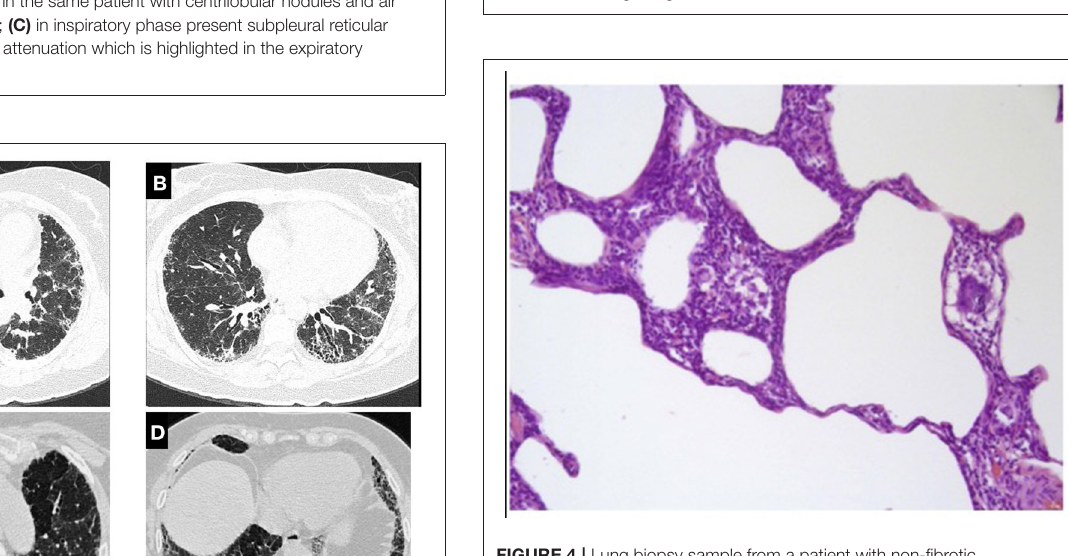
has experience with this technique), or surgical lung biopsy where samples of two different lobes are indicated (41–43).